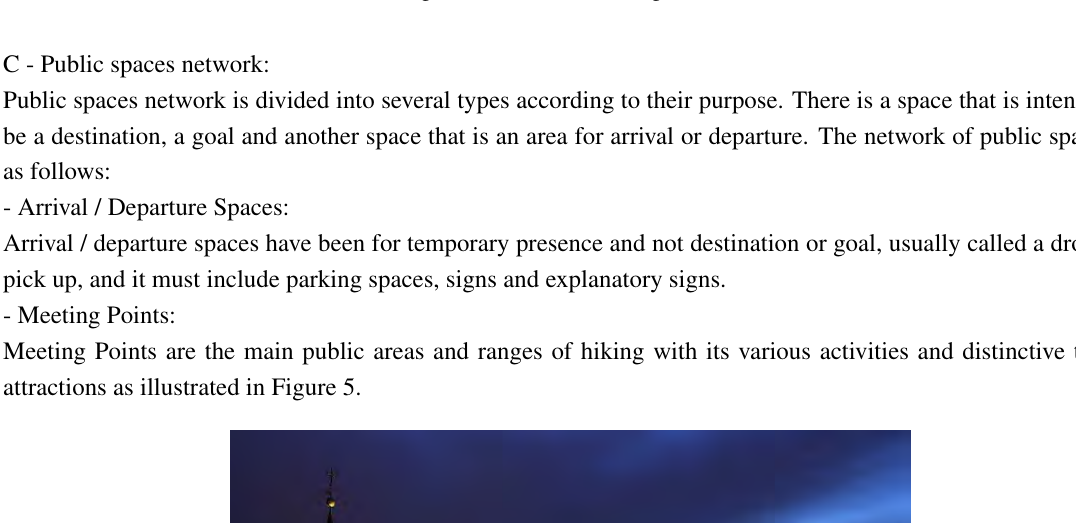
Figure 5. (Minor Connecting Routes)